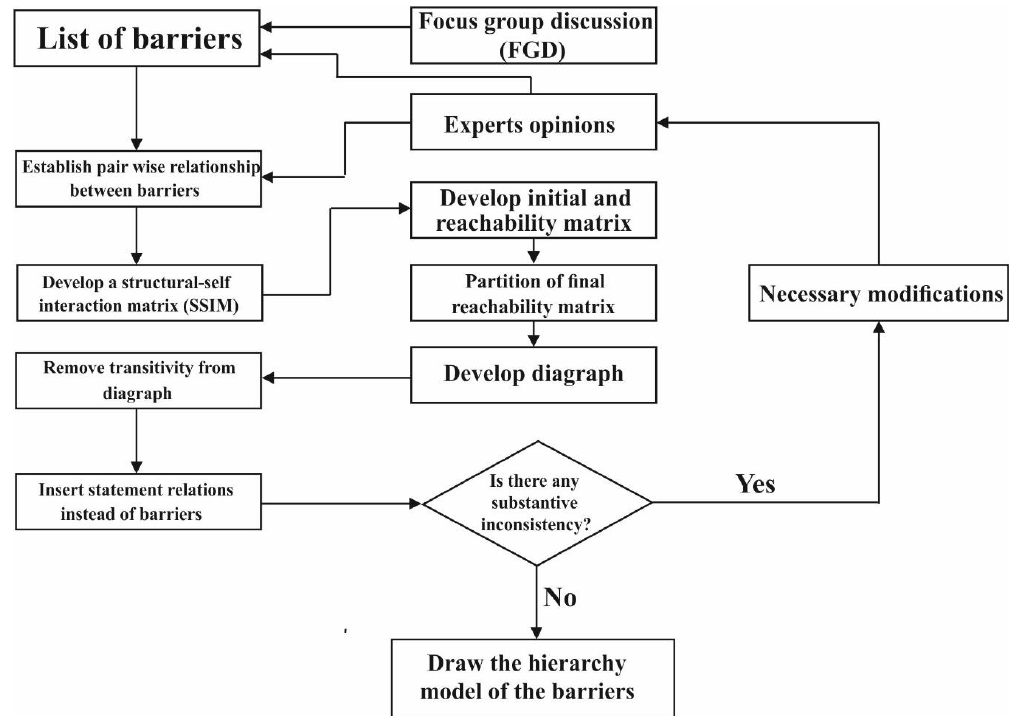
Figure 3. Flowchart for preparing interpretive structural modeling (ISM).